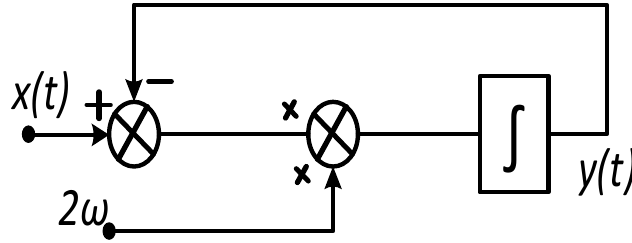
Figure 6. Control layout of FOGI .